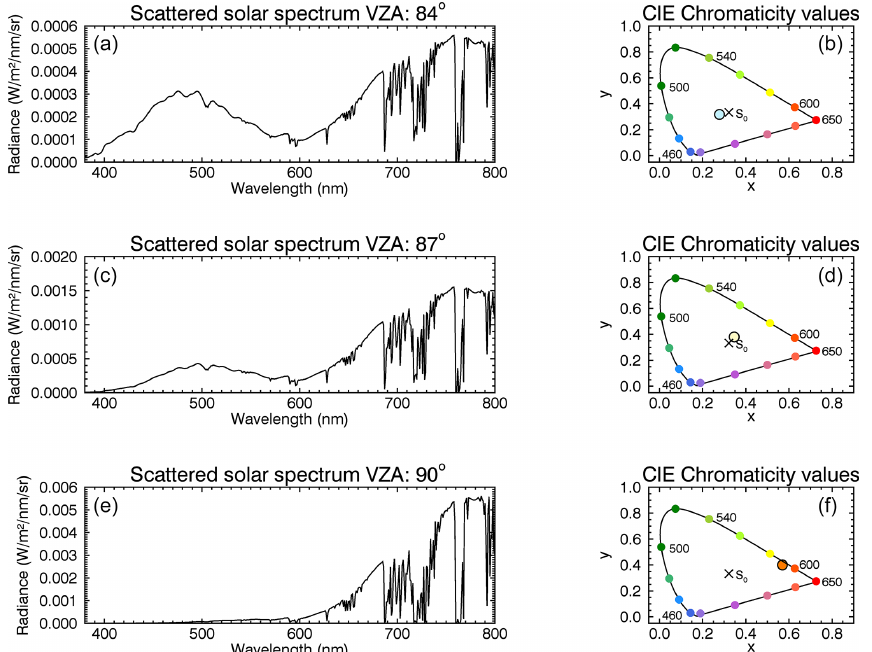
Figure 11. Solar scattering spectra (a, c, e) and CIE chromaticity diagrams (b, d, f) for an observer on the Earth’s surface and for SZA = 98 ◦ ; VZA = 84, 87, and 90 ◦ (from top to bottom); and SAA = 0 ◦ . The calculated spectra show the background without NLCs.